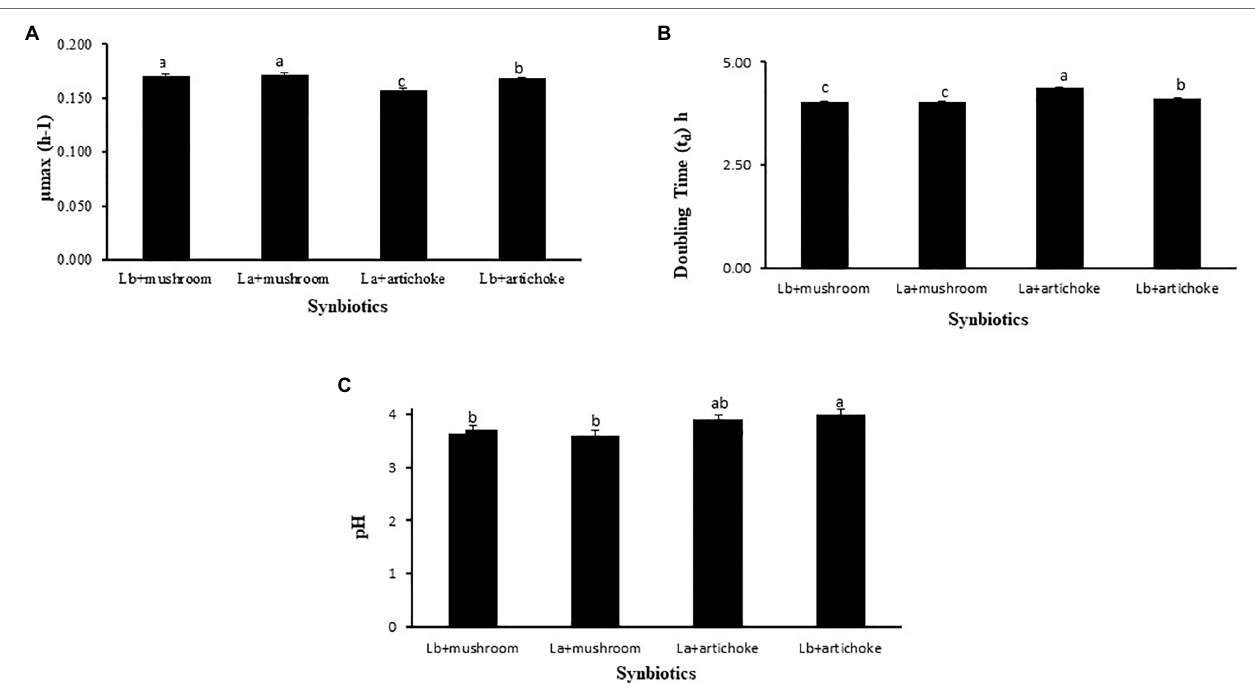
FIGURE 5 | Comparison of the (A) specific growth rate ( μ max; h − 1 ), (B) doubling time (T d ; h), and (C) pH of the medium of L. acidophillus with that of L. delbrueckii subsp. bulgaricus grown in MRS medium containing 50% mushroom or 100% artichoke extract. Bars with different letters indicate a significant difference ( p < 0.05). Data are presented as mean ± SE.